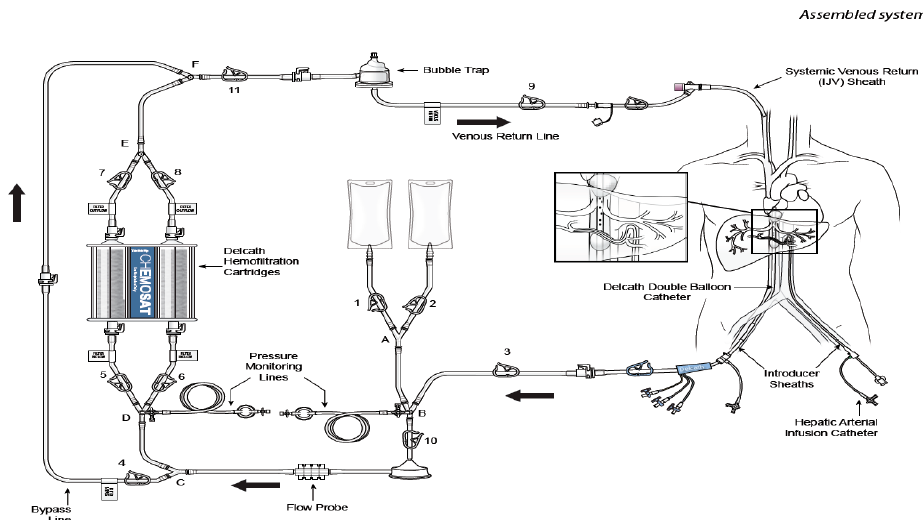
Figure 1. Cartoon reproducing the CHEMOSAT ® percutaneous hepatic perfusion (CS-PHP) Hemofiltration Circuit with extracorporeal circulation (Delcath Systems permission). Effective treatment of non-resectable primary and secondary liver tumors remains a major challenge in interdisciplinary oncology, with the general objective of expanding clinician roles towards loco-regional treatments and, in particular, to earn patients some time in terms of longer disease control and good quality of life.